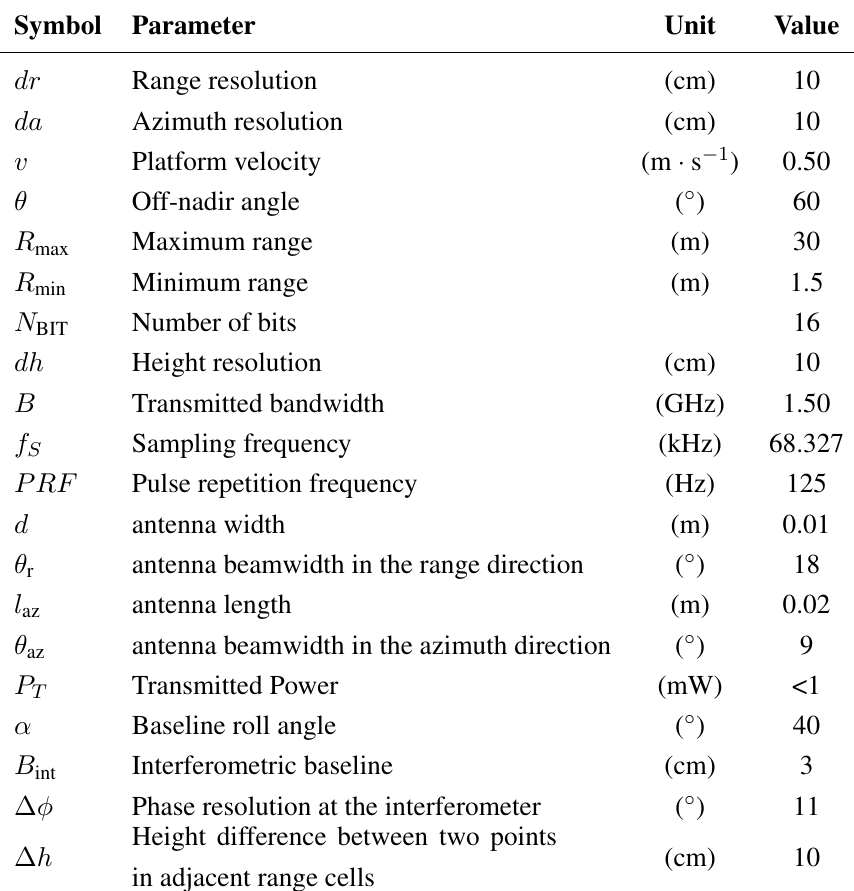
Table 5. Selected working